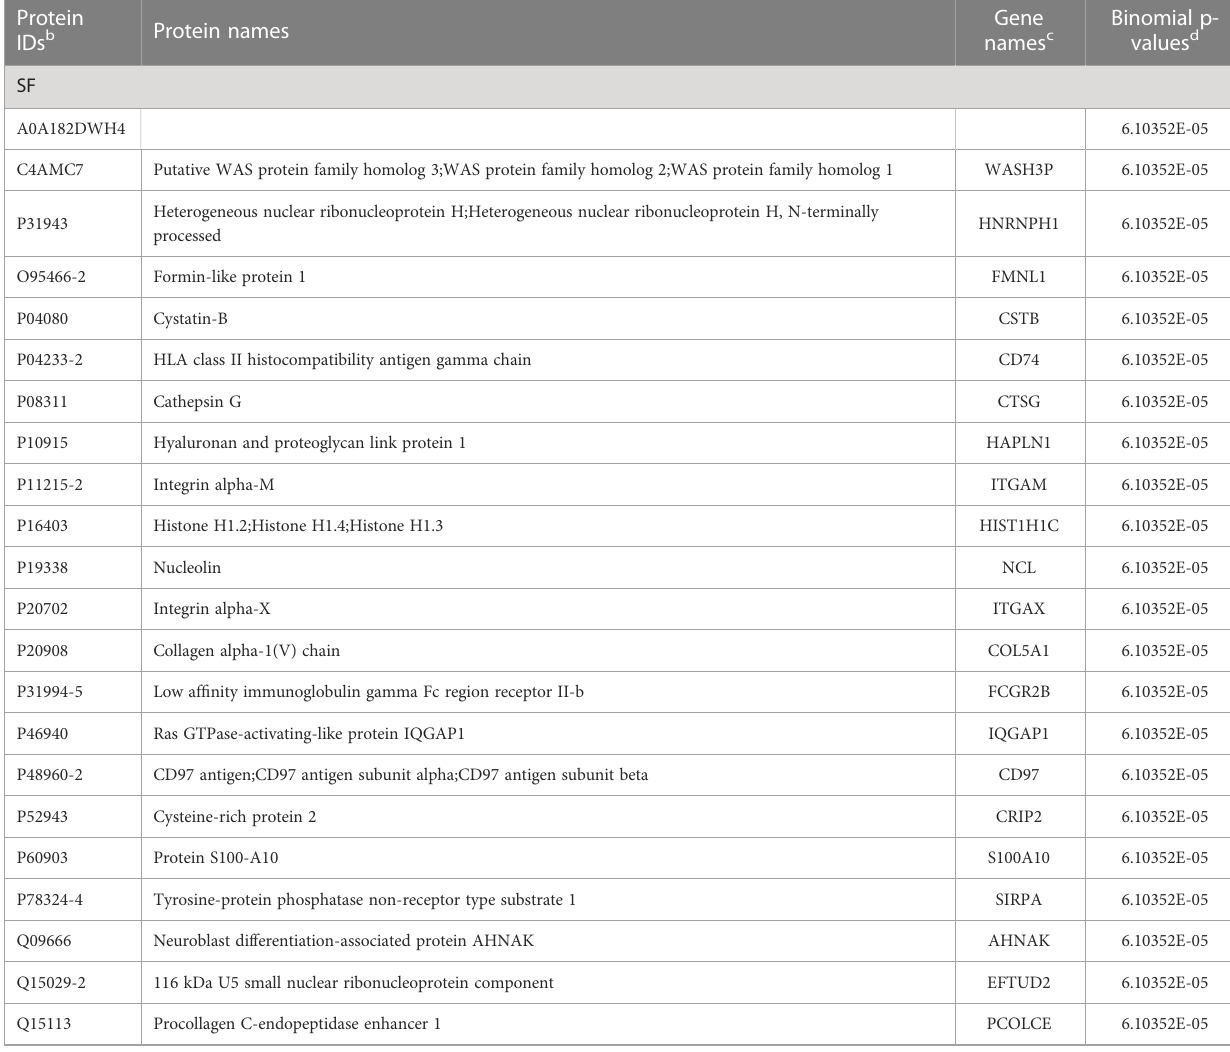
TABLE 3 List of EV-prots exclusively expressed in SF_OJIA respect to PL_OJIA samples a . Protein Protein IDs b